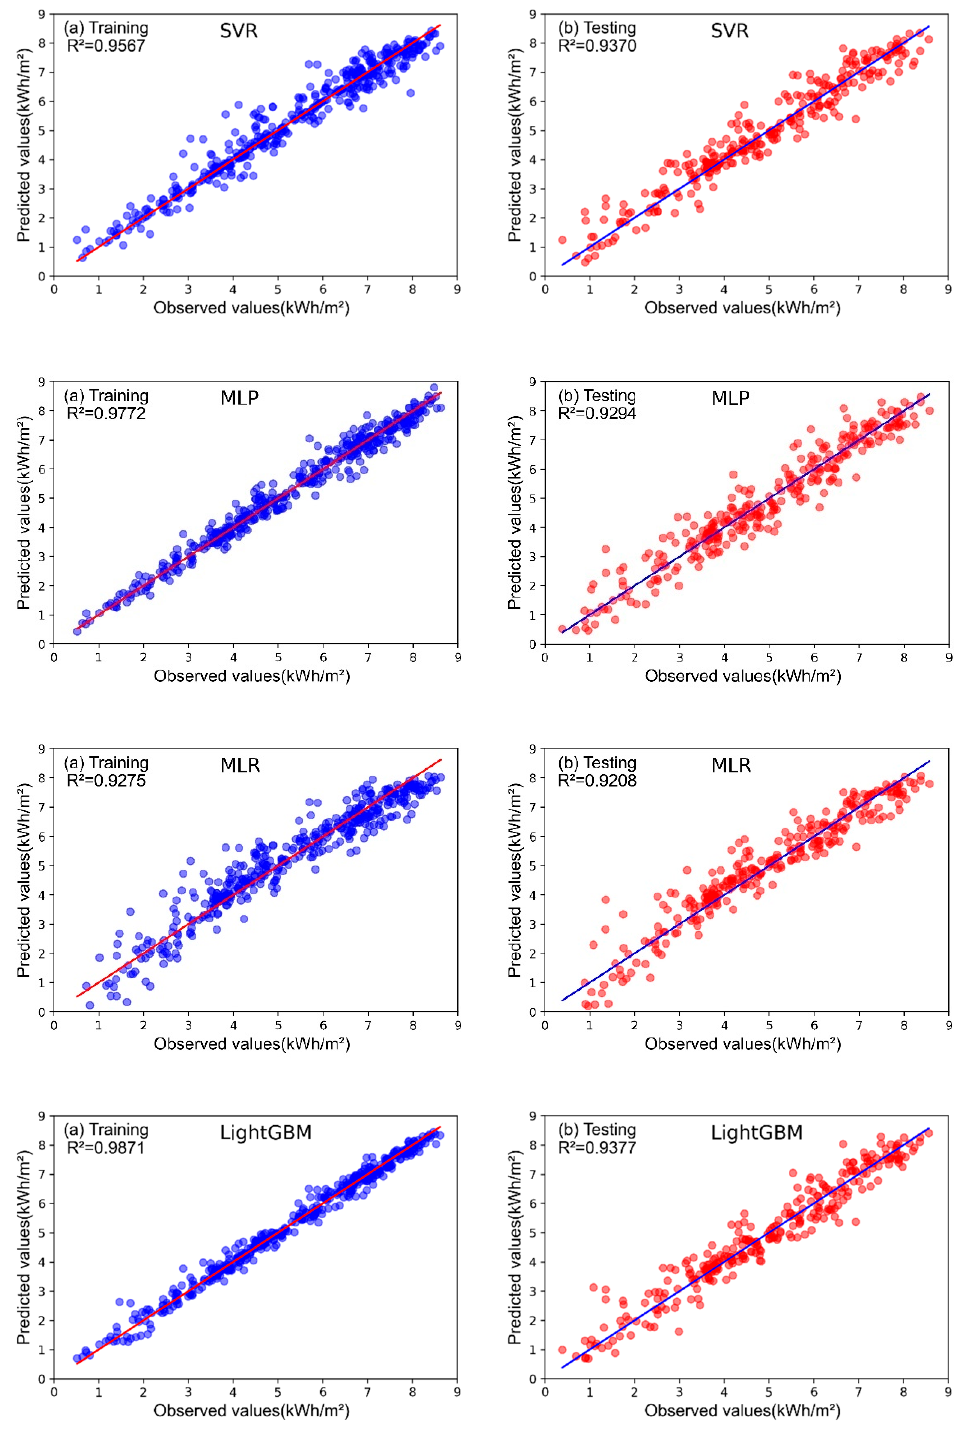
Figure 5. Scatter plots for the predictive models SVR, MLP, MLR, and LightGBM between predicted and observed solar radiation for ( a ) training and ( b ) testing.